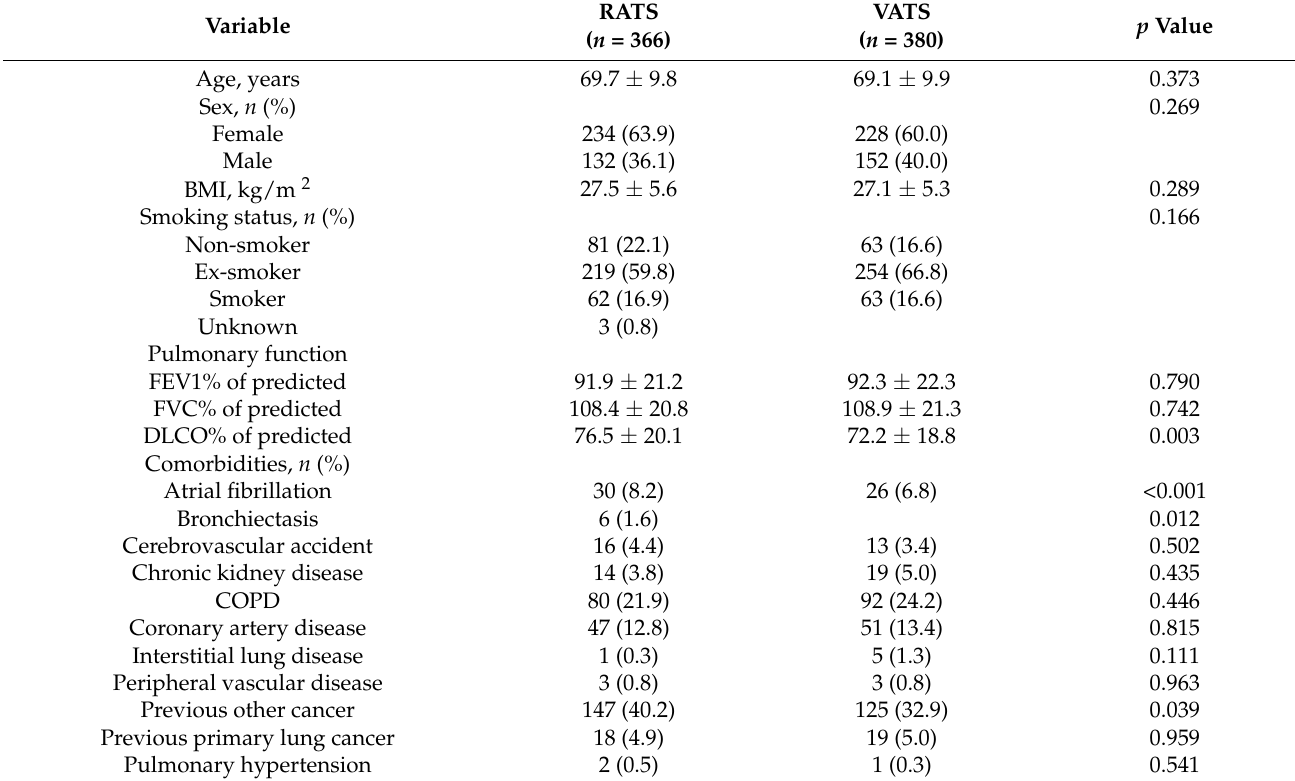
Table 1. Patient characteristics 1